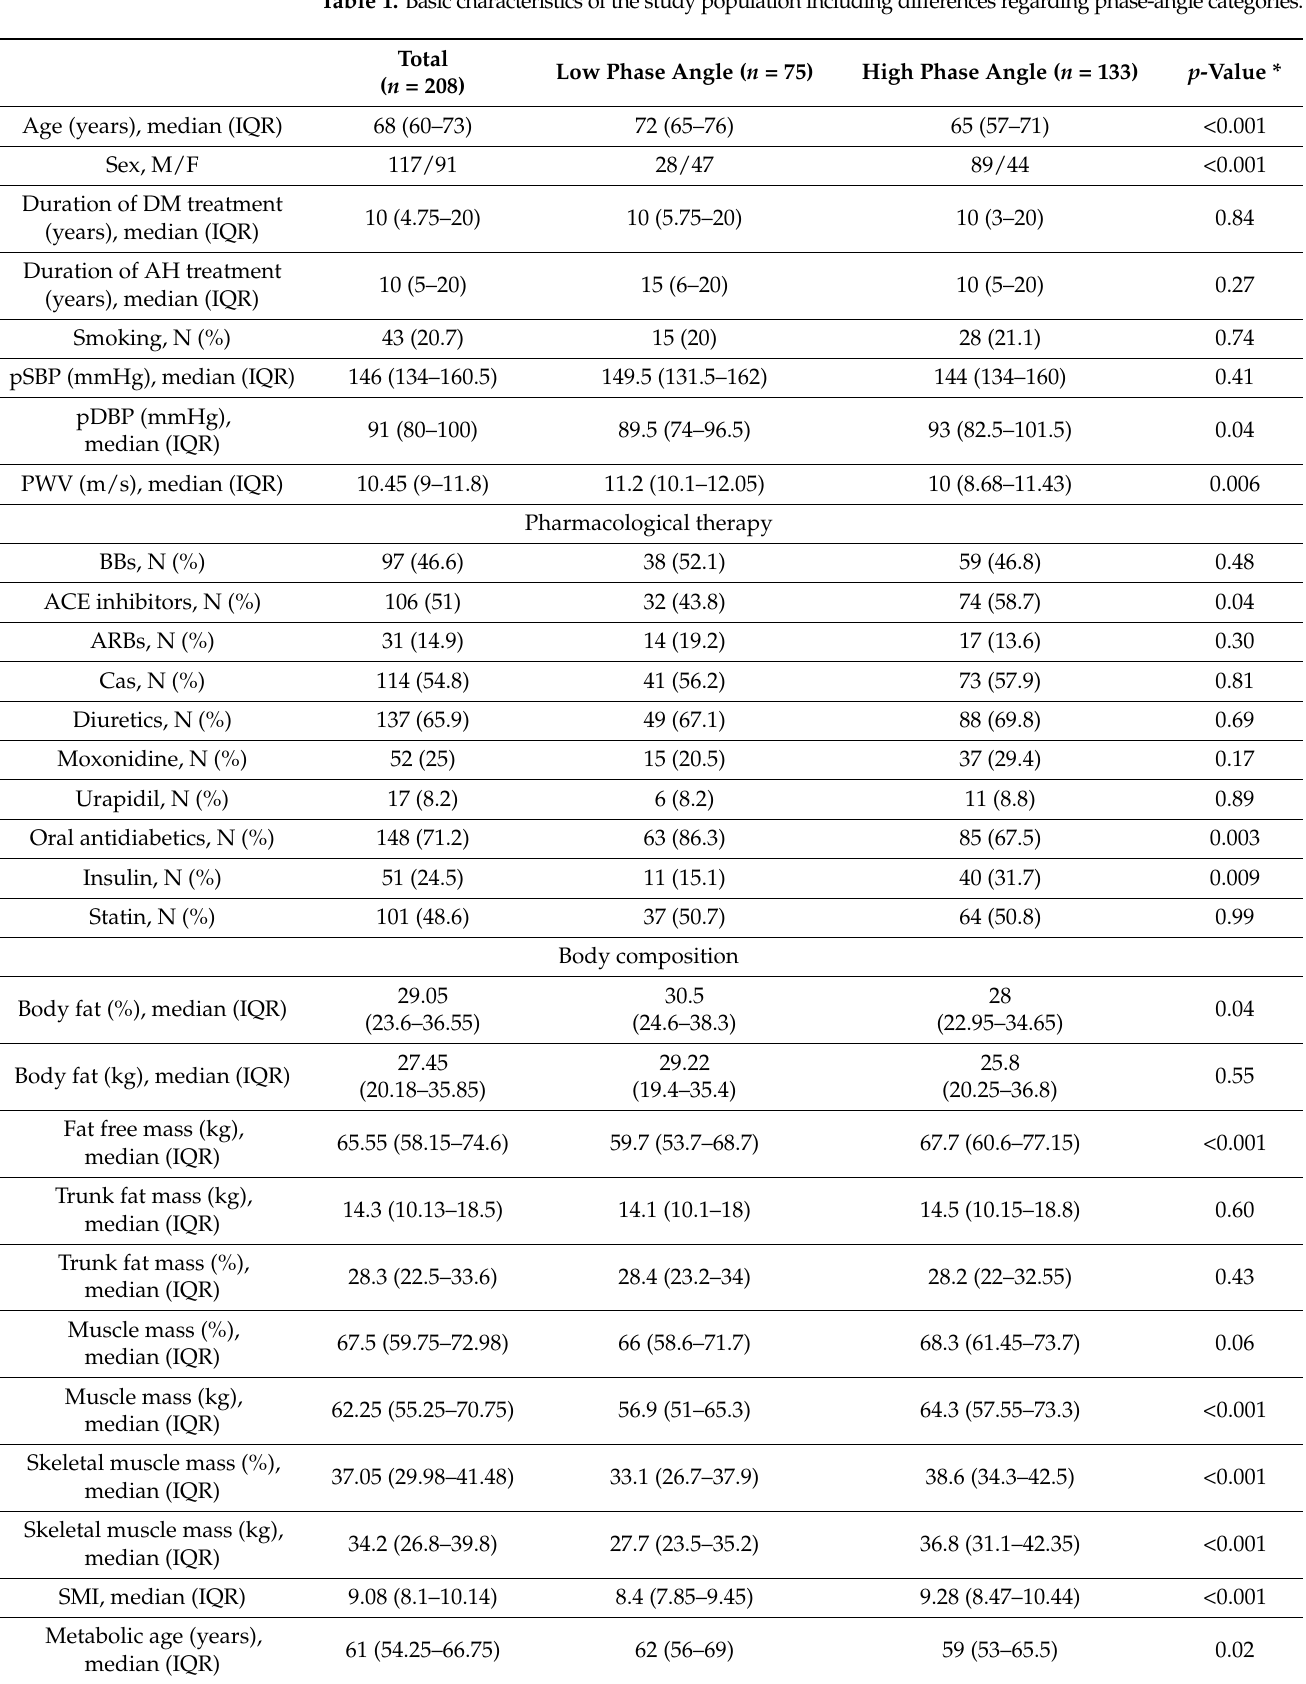
Table 1. Basic characteristics of the study population including differences regarding phase-angle